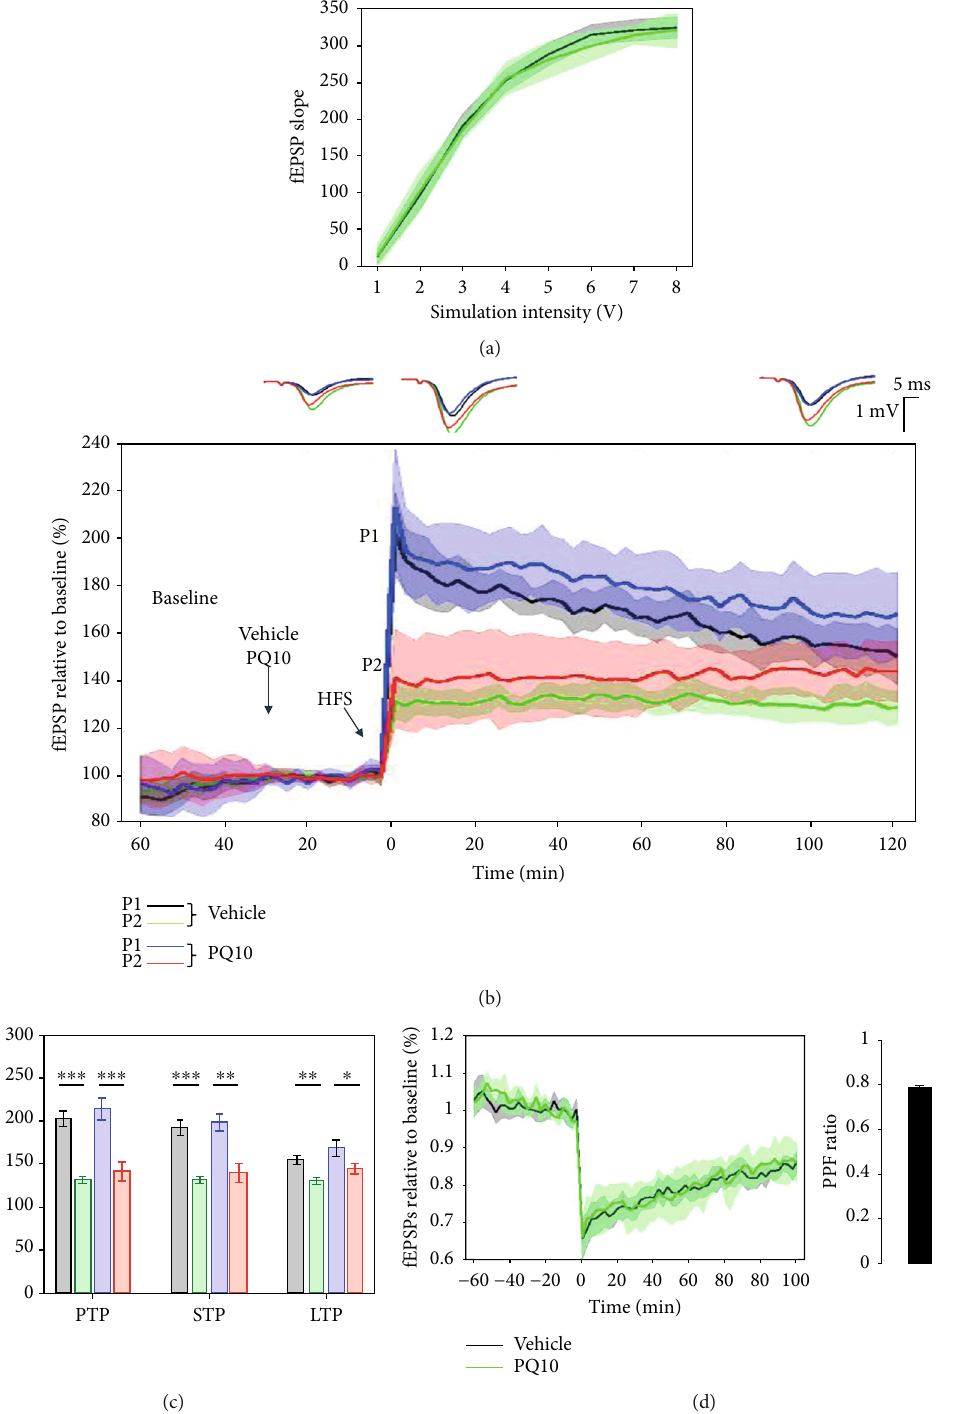
Figure 14: PQ10 did not a ff ect fi eld postsynaptic potentials (fEPSP1 and fEPSP2) and paired-pulse facilitation (PPF) recorded at the SC-CA1 synapse during LTP. (a) Collective input/output curves between stimulation voltage and fEPSP slope overlap, showing no signi fi cant di ff erence in basal synaptic excitability. (b) PQ10 ( n = 6 ) did not alter the induction and maintenance of LTP response measured from the slope of the fEPSP1 (blue) and fEPSP2 (red) as compared to vehicle-treated subjects (black and green, respectively, n = 10 ). Values represent averages ± 95 % confidence intervals . Outsets above LTP curves represent average waveform fi eld potentials during 30min baseline prior to tetanisation and 0-30min and 90-120min posttetanisation. Horizontal bar: 1 mV; vertical bar: 5 ms. (c) PTP, STP, and LTP responses are presented as means ± 95 % confidence intervals . ∗ p value < 0 : 05 ; ∗∗ p value < 0 : 01 ; and ∗∗∗ p value < 0 : 001 . (d) No di ff erence in the paired-pulse facilitation of PQ10-treated and vehicle-treated subjects. The bar plot showing average PPR values during the 2-hour posttetanisation showed no signi fi cant di ff erence between PQ10- and vehicle-treated